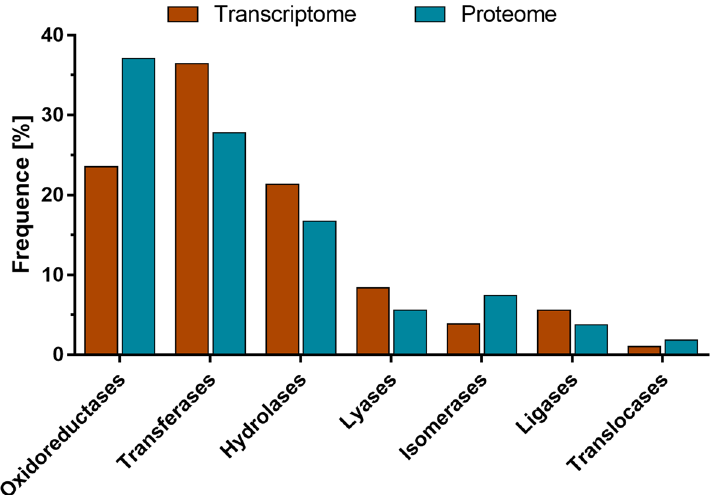
Figure 4. Enzymes distribution. Frequency of molecules identified using the KEGG databases for the pararama transcriptome and proteome. The figure was drawn using GraphPad Prism version 7.0 (www.graph